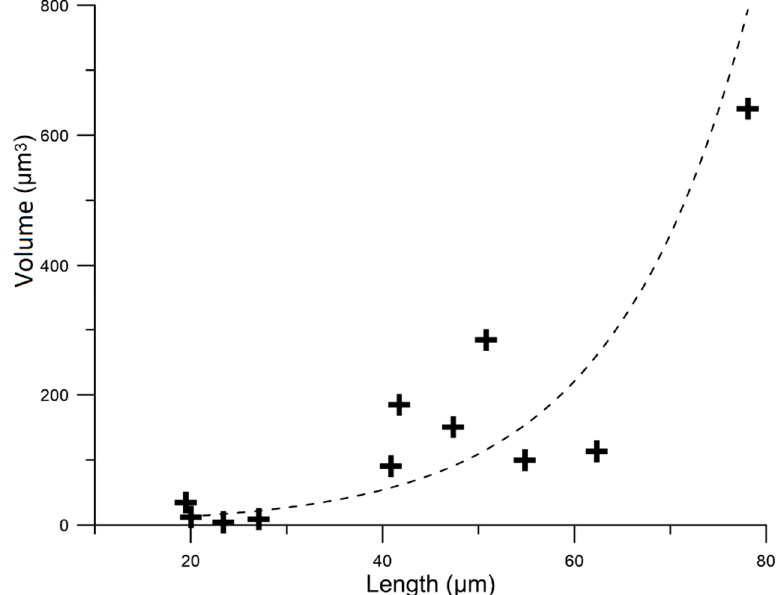
Figure 10. Scatter plot showing the volume of the ABs vs. the length of coated fibres. Dashed line represents an exponential fitting function (R 2 = 0.70) to the data points.